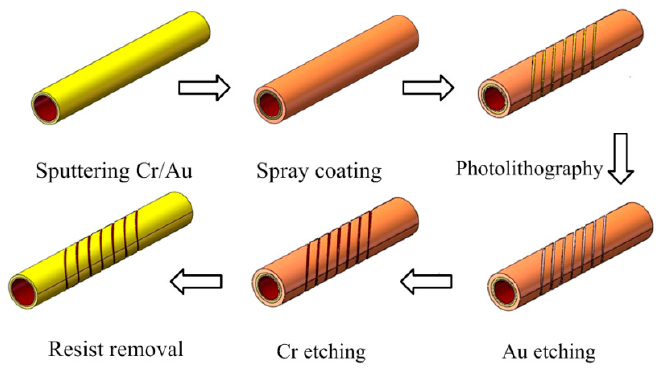
Figure 7. Main fabrication process of the tilted microcoil.